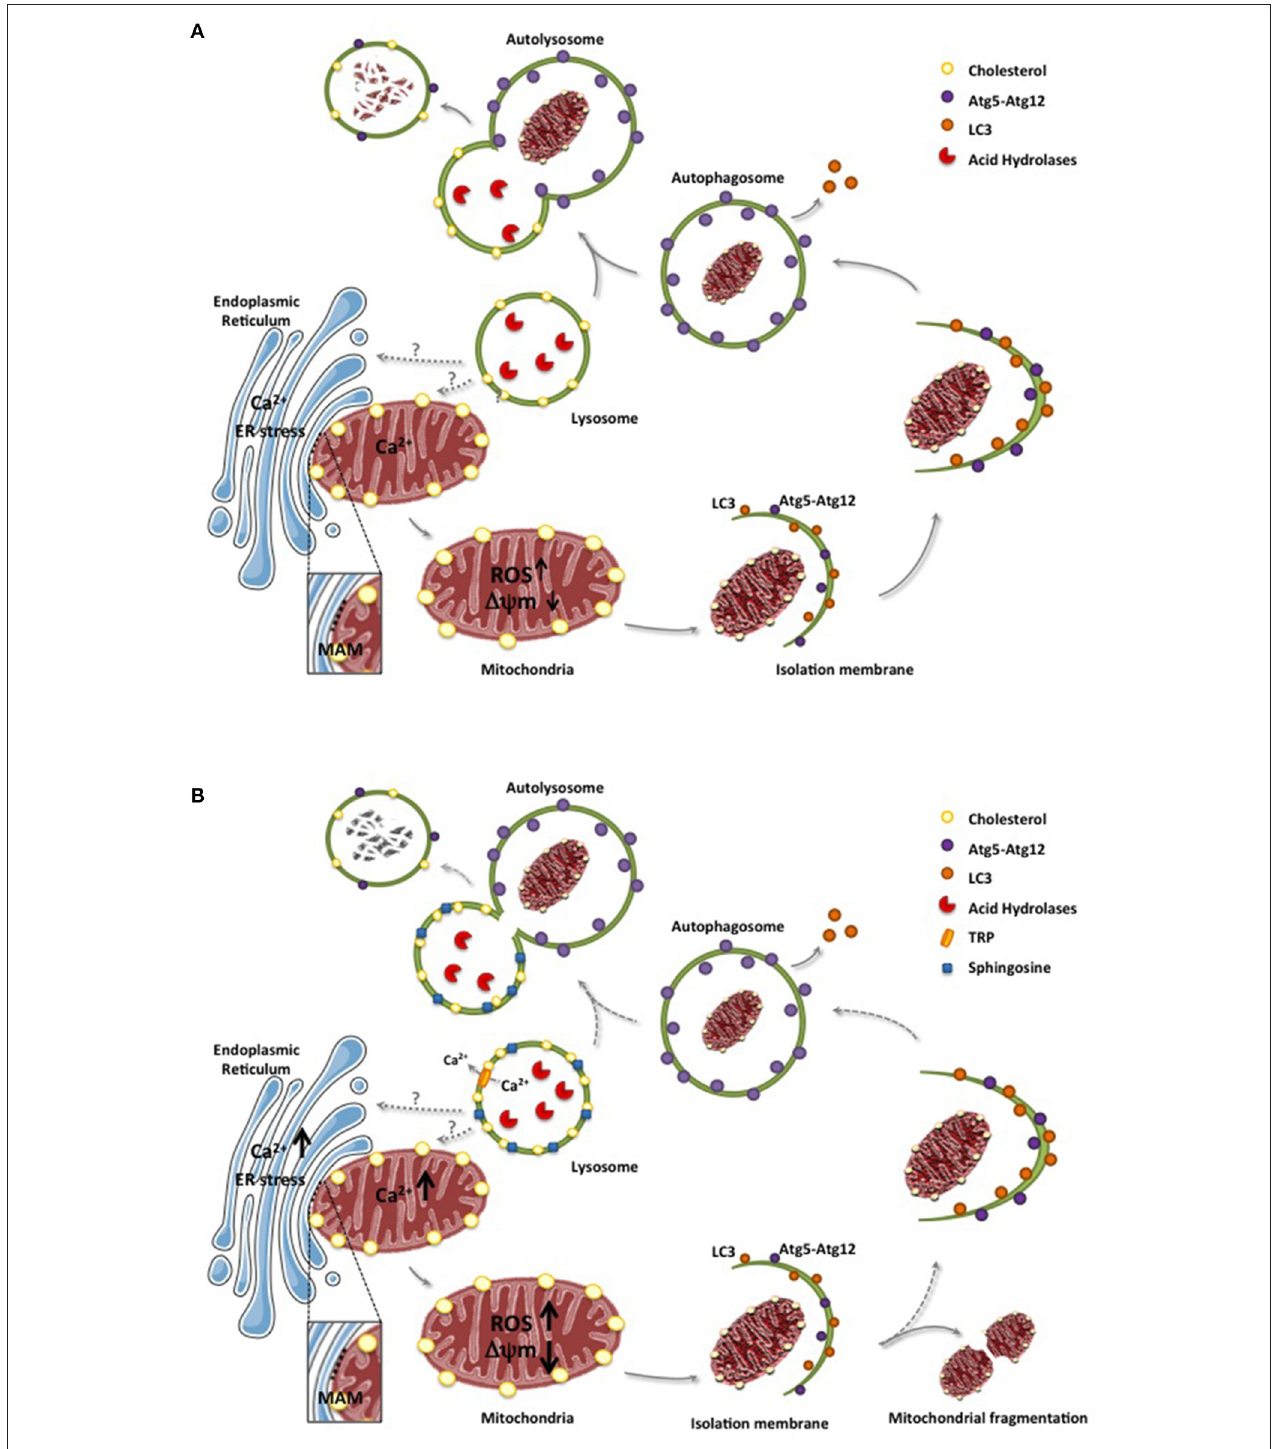
FIGURE 1 | ER and lysosomes in mitochondrial degradation. (A) , Mitochondria and ER interaction through MAMs contributes to the uptake of calcium to mitochondria, which in physiological conditions do not cause mitochondrial dysfunction. However, in conditions of ER stress, enhanced flux of calcium from ER to mitochondria can cause oxidative stress, increased generation of reactive oxygen species (ROS) and mitochondrial depolarization. As a mechanism to ensure the elimination dysfunctional mitochondria, altered mitochondria is engulfed in sequential structures originating with the isolation membrane, which evolve to form